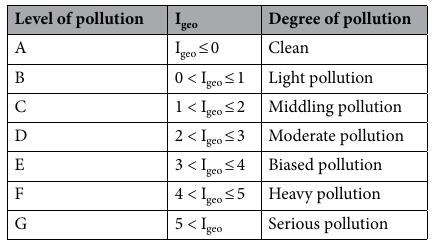
Table 3. Standard for evaluation of soil pollution degree by land accumulation